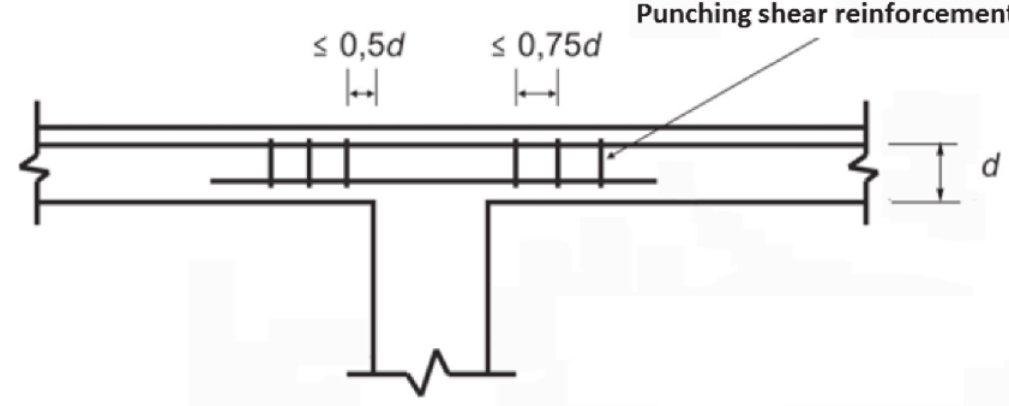
Model using stirrups for shear reinforcement Source: NBR